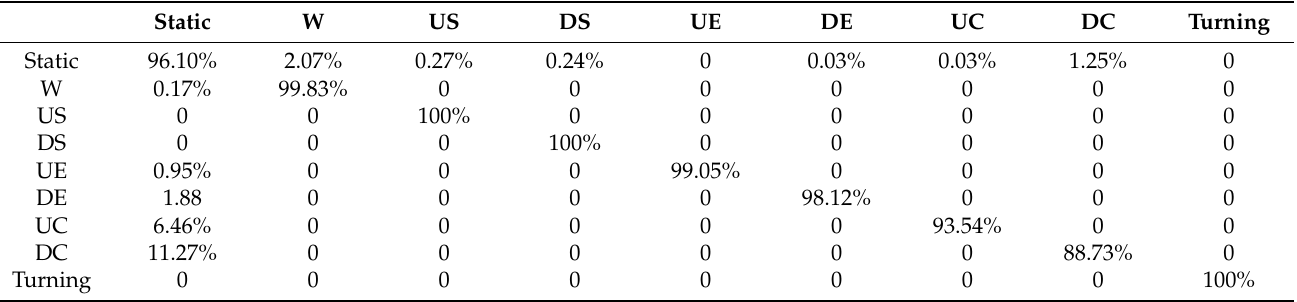
Table 11. Motion mode recognition